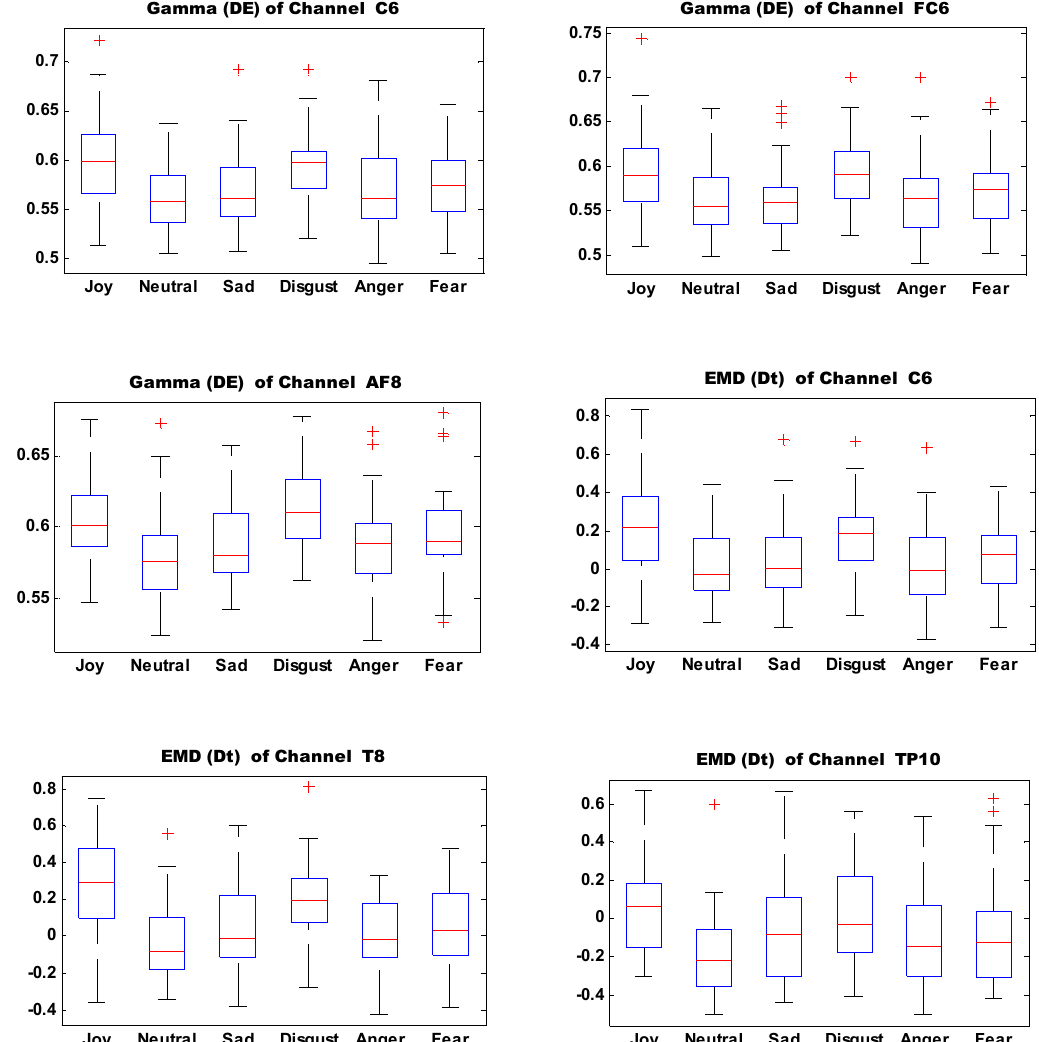
Figure 13. Distribution of 10 important electrode features associated with self-induced emotion.